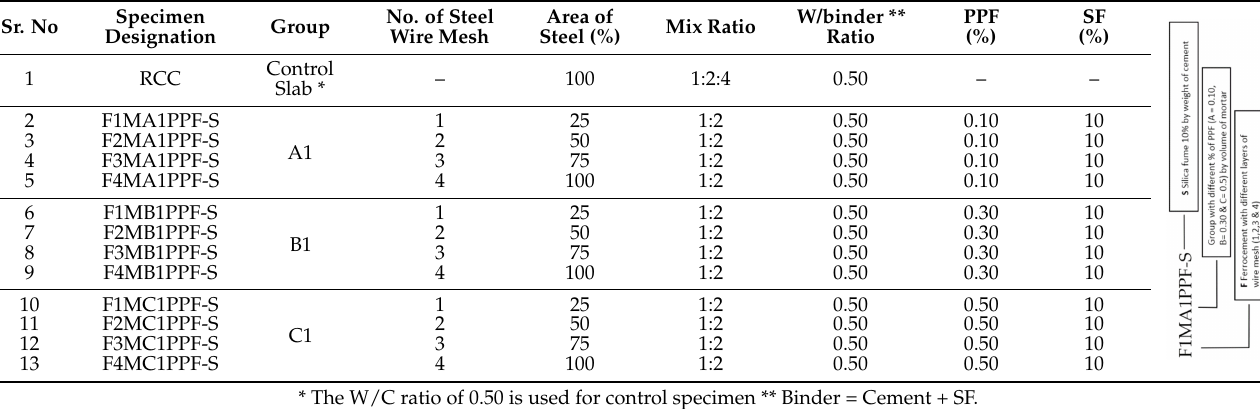
total of 36 mortar cubes were cast and tested at 3, 7 and 28 days of curing age. The results and discussion section presents the average values for the compressive strength of these cube specimens. A total of 12 ferrocement slab specimens and one control slab were cast and tested in flexure under 3-point loading as per ASTM C 78-02 [56]. The slabs were supported with a clear span of 1016 mm (40 inches). The experimental setup is shown in Figure 7. A proving ring of 3000 kN (674,426.83 lbf) capacity was used along with a hy- draulic jack, steel plates and girders. The load was applied using a hydraulic jack in small increments; the mid-span deflection and strain of the center of the slab were recorded up to failure using linear variable displacement transducers (LVDT) and strain gauges. The increment of load in the proving ring was kept uniform (5 division interval) to observe the overall behavior of ferrocement and control slabs. The applied load and deflection were recorded in kilonewton (kN) and millimeters (mm). For every increment of load, the readings of LVDTs were carefully noted. The strain gauges were used to measure the strain response, and the data logger P-3 box recorded the data. After testing of slabs, their deflections and strains were noted. The following formula was used to calculate the flex- ural strength.